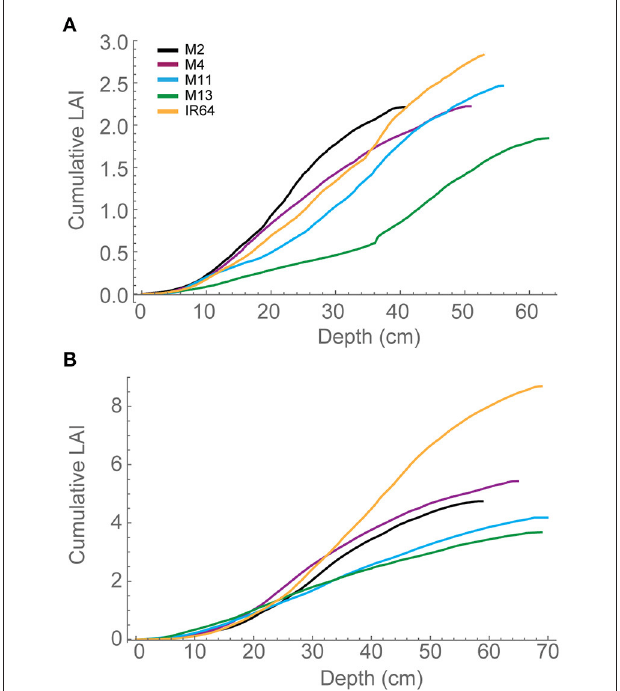
FIGURE 2 | Modeled cLAI, the area of leaf material (or mesh area) per unit ground as a function of depth through the canopy (i.e., distance from the top) at 12:00 h for (A) GS1 and (B) GS2. M2, M4, M11, and M13 refer to Shan-Huang Zhan-2 (SHZ-2), IR4630-22-2-5-1- 3, 157 WAB 56-125, and Inia Tacuari,